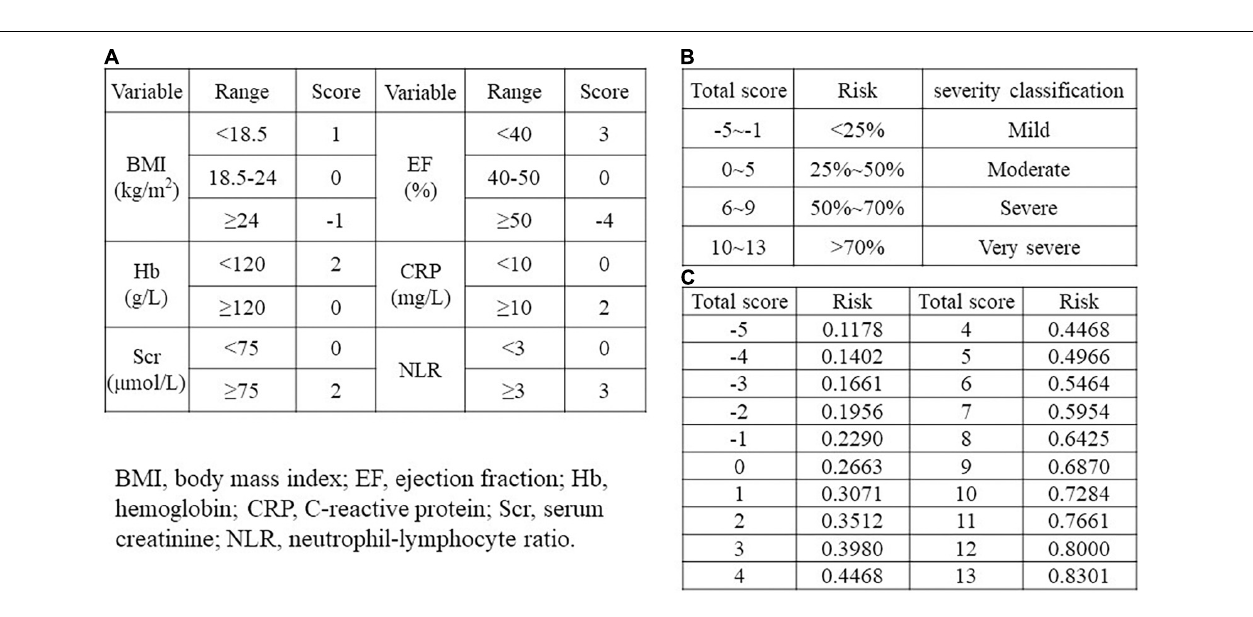
FIGURE 2 | Risk score model. (A) Scores corresponding to different ranges of each independent predictor. (B) Risk stratification corresponding to total scores in different ranges. (C) A separate risk level for each total score. BMI, body mass index; EF, ejection fraction; Hb, hemoglobin; CRP, C-reactive protein; Scr, serum creatinine; NLR, neutrophil-lymphocyte